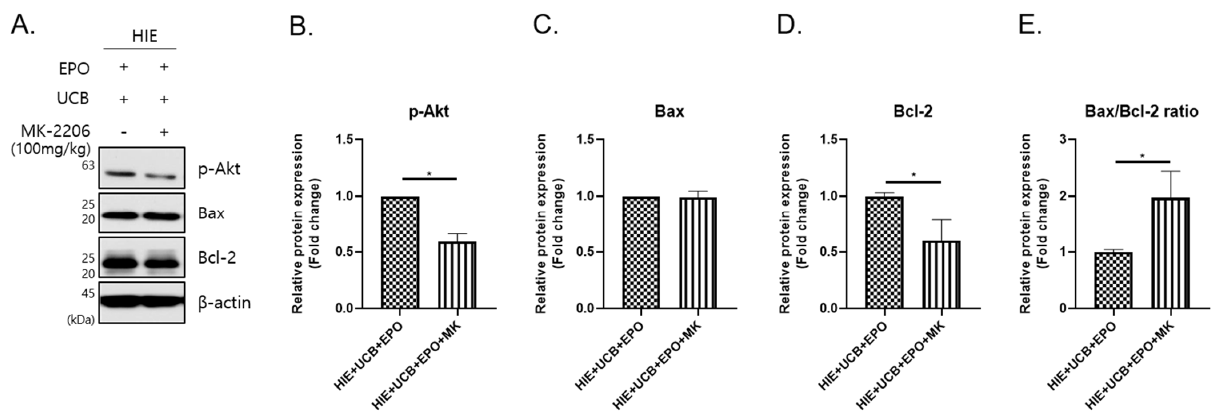
Figure 5. Anti-apoptotic effect inhibits by MK-2206 (Akt inhibitor) in hUCB and rhEPO combination treatment. ( A ) The levels of p -Akt, Bax, and anti-apoptotic protein, Bcl-2, by phosphorylation of Akt were detected using Western blotting. ( B – D ) The graphs depict the band intensity by imageJ program for band of image A, and ( E ) represent Bax/Bcl-2 ratio. Data shown as the mean ± standard error of mean. n = 4 to 5 per group, * p < 0.05 (one-way ANOVA).